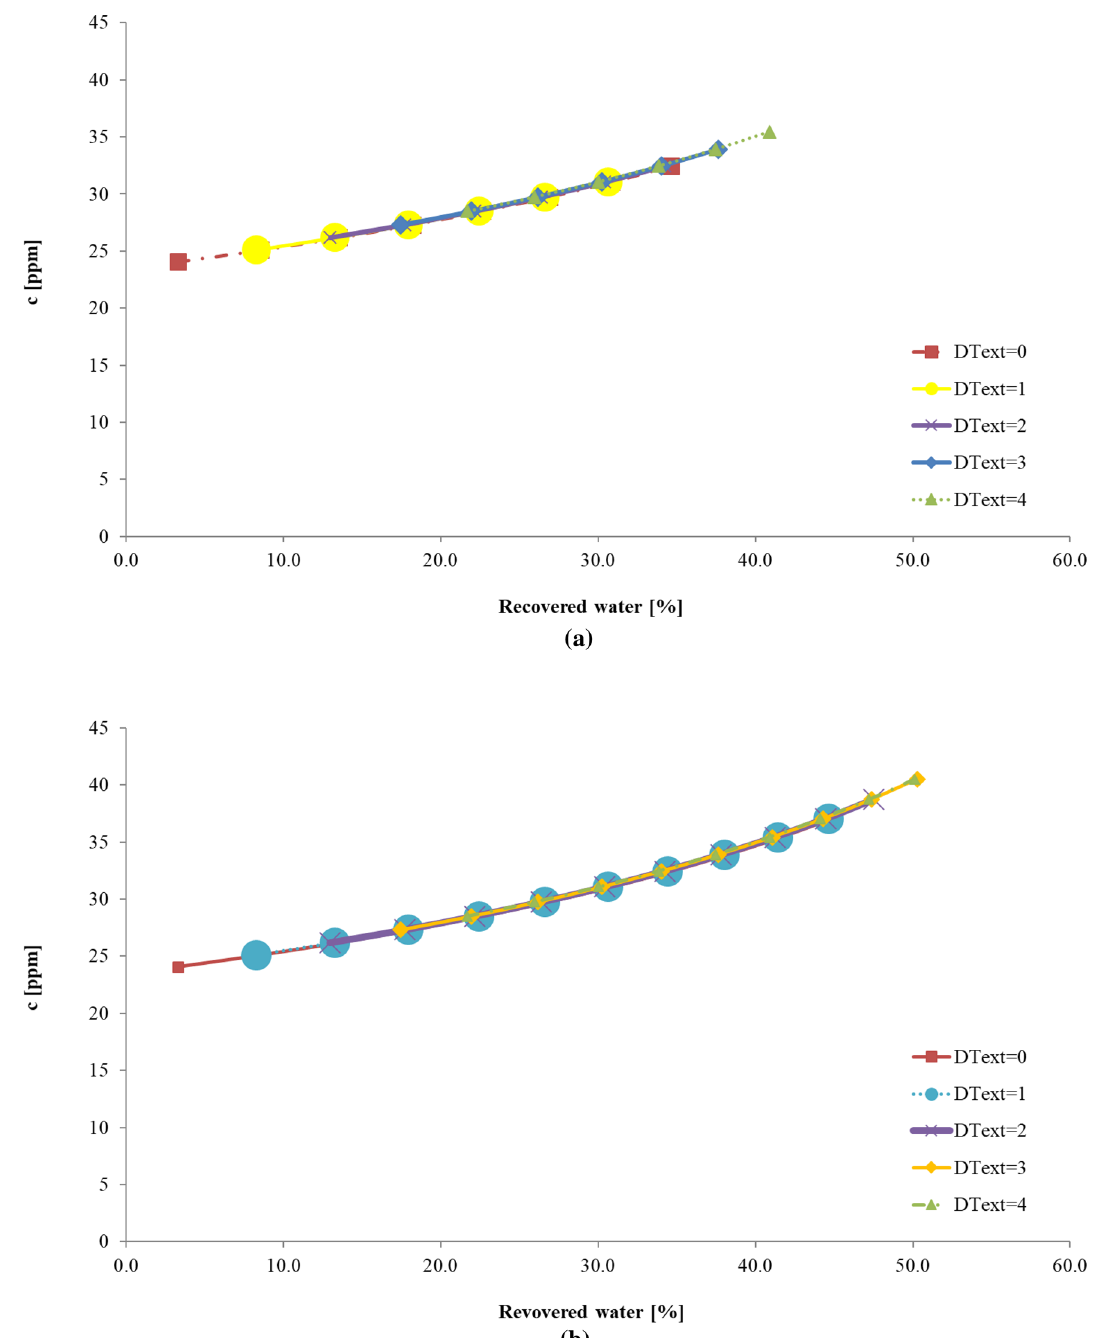
Fig. 12 Variation of ammonia concentration in water recovered for configuration 3 at increasing ΔT of the figures) and at a I = 5 and b I = 10. (Feed: RH = 100%, T = 45